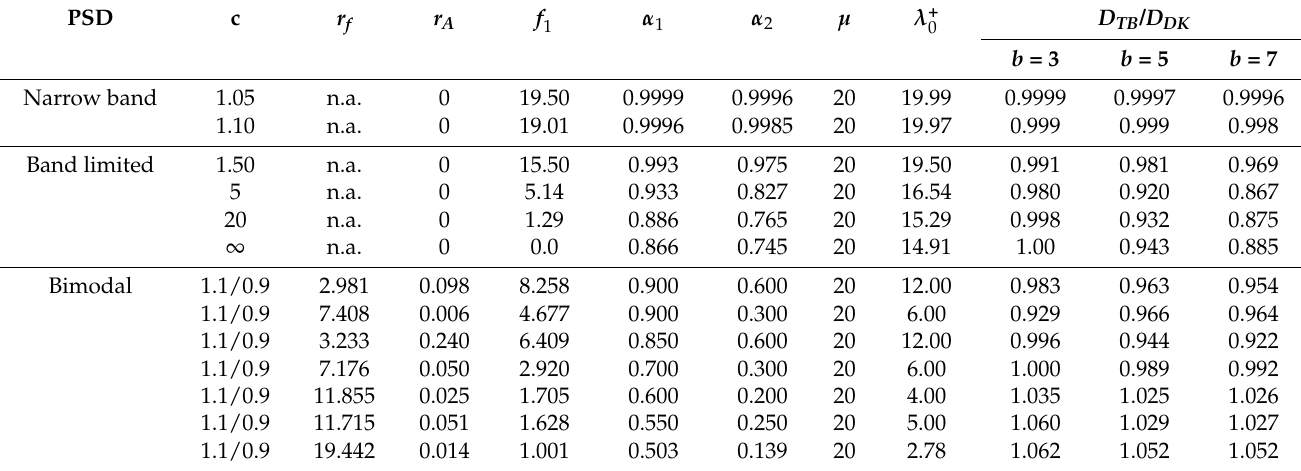
crossing per second, n.a. = not 0